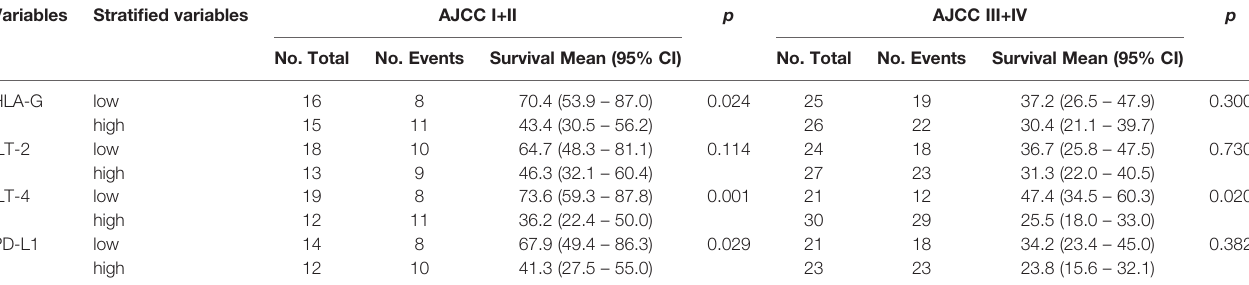
TABLE 3 | Log-rank Mantel-Cox analysis of strati fi ed variables in survival by tumor AJCC status in CRC patients.